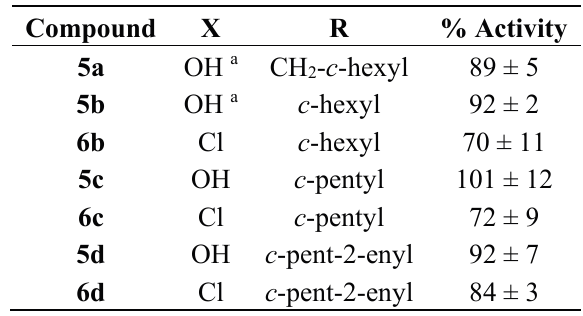
Table 3. % Activity of OGG1 in the presence of compounds 5 or 6 at 0.2 mM concentration.